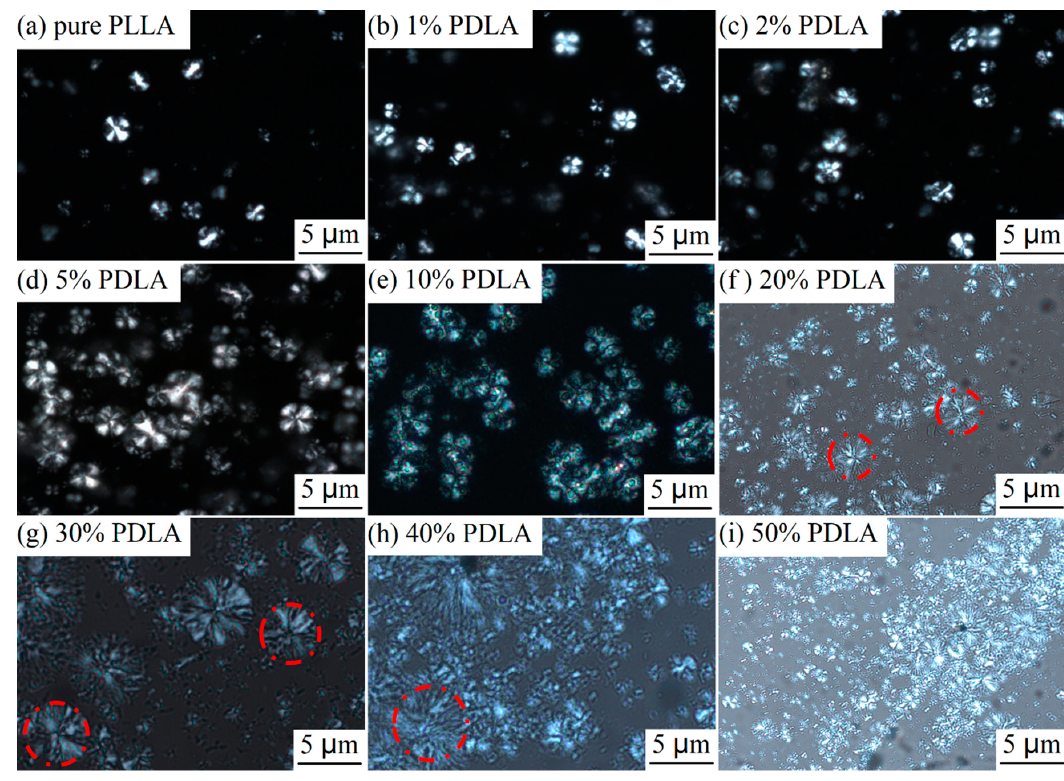
Figure 2. POM images of ( a ) pure PLLA and ( b – i ) PDLA/PLLA blends with different PDLA contents.